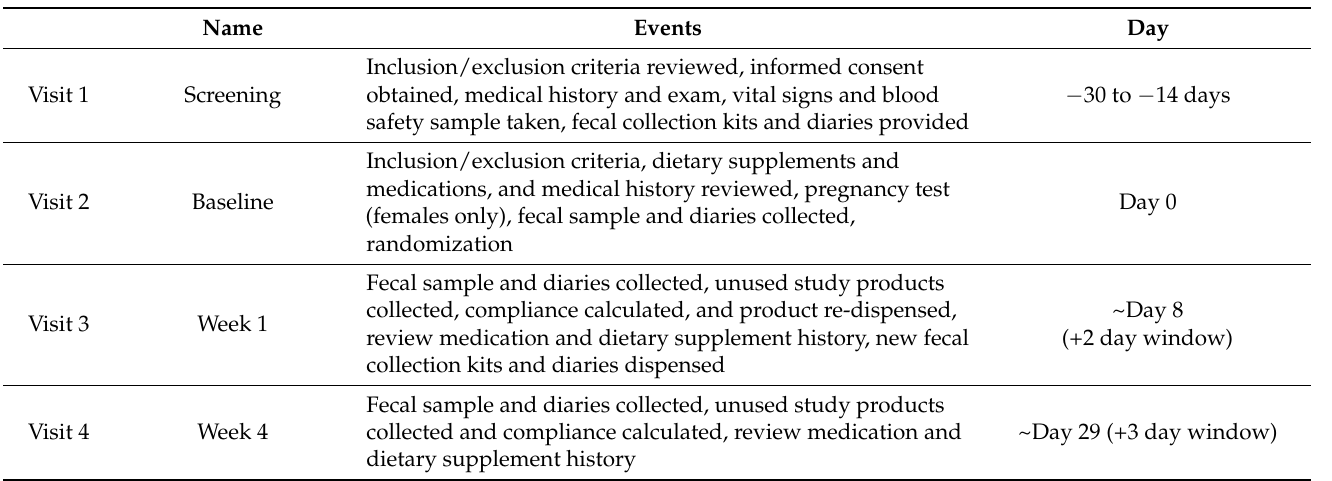
Table 2. Study visits and timeline of